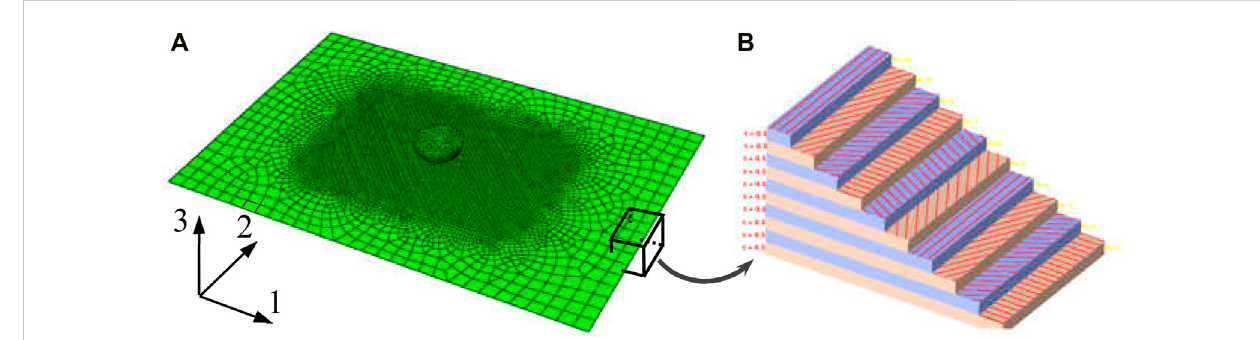
FIGURE 2 Impact analysis model of biomimetic composites. (A) Finite element model for impact analysis, (B) fi ber arrangement direction of composite material (red indicates fi ber).